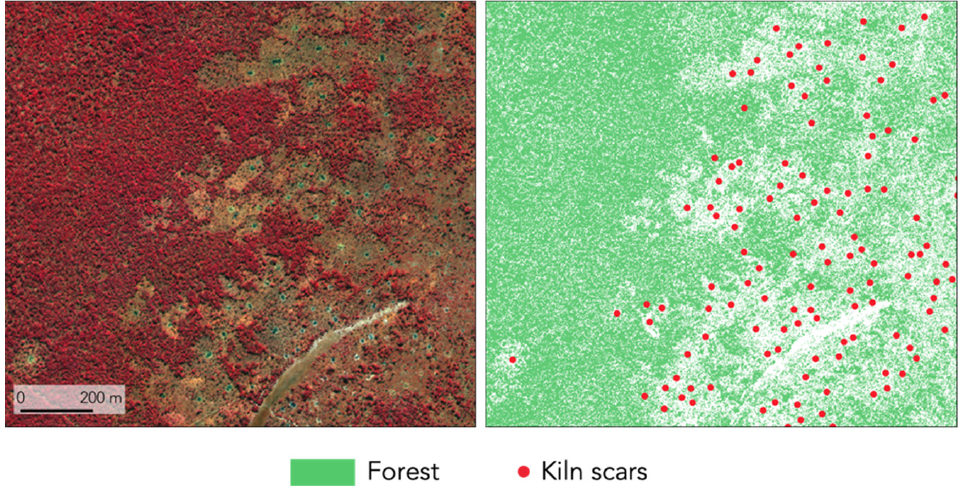
Figure 8. Kiln scars automatically mapped from high-resolution images in Mkushi forest reserve. Left side panel: False-color composition (1,2,4) of WorldView-2 image (year 2016); right side panel: visualization of tree cover and kiln scars.